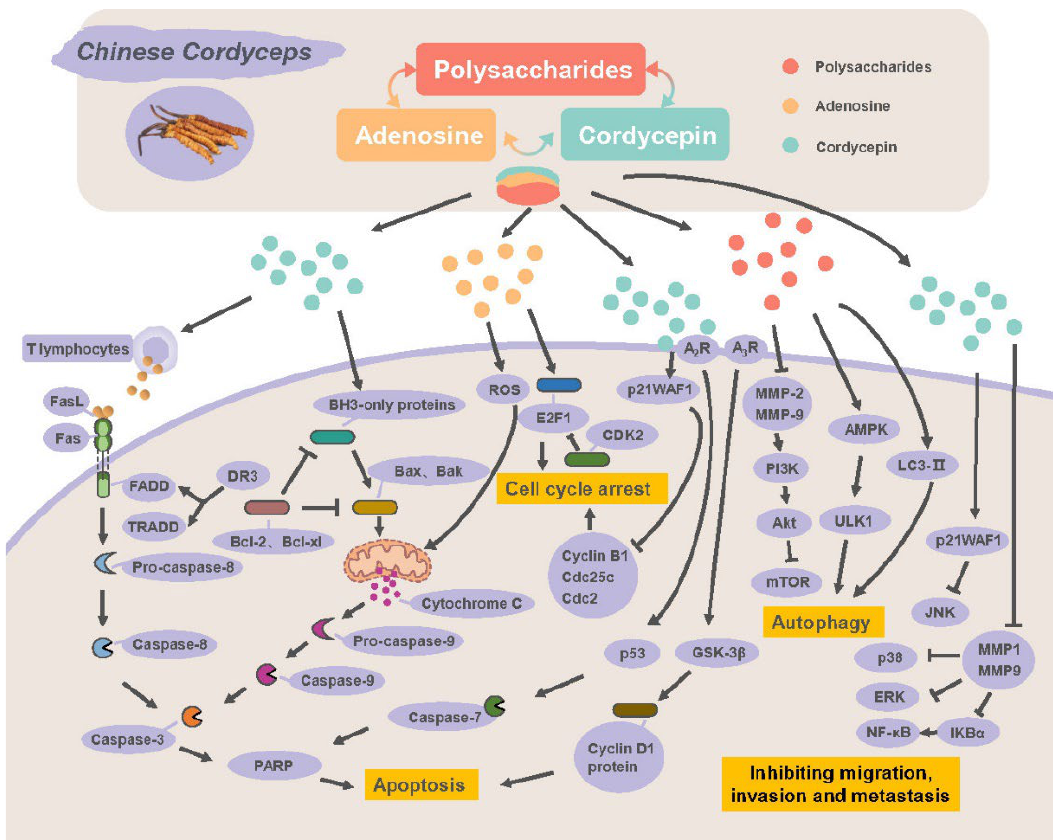
Figure 3. Possible mechanisms of antitumor activity of Chinese Cordyceps.